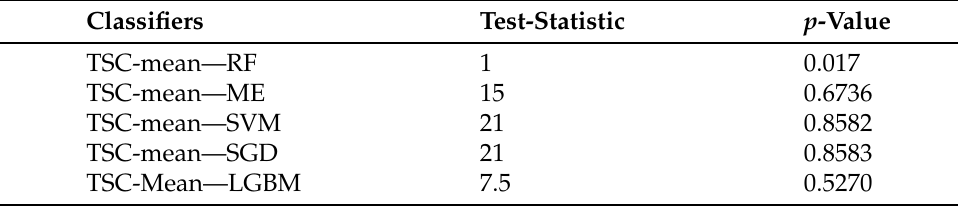
Table 11. Wilcoxon signed-rank